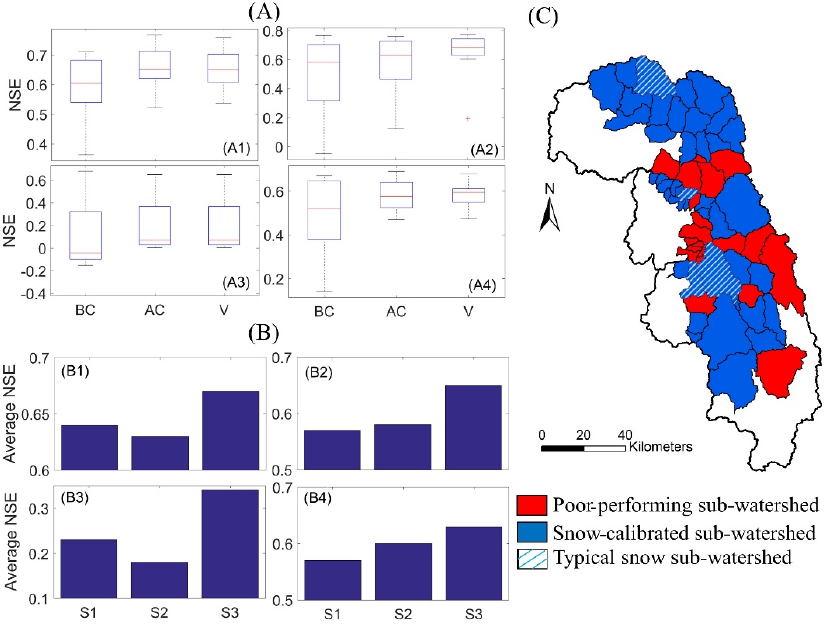
Figure 5. SWE calibration and validation results for the three calibration scenarios